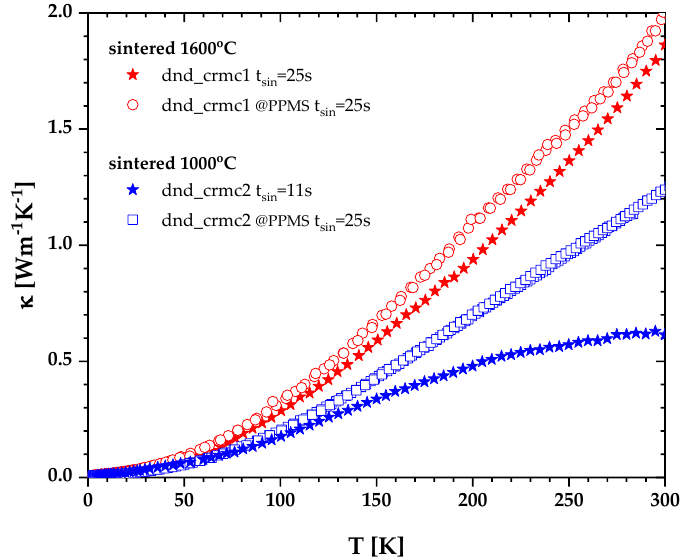
Figure 3. Thermal conductivity as a function of temperature for detonated nanodiamond ceramic samples sintered at different temperatures and measured in two different setups.